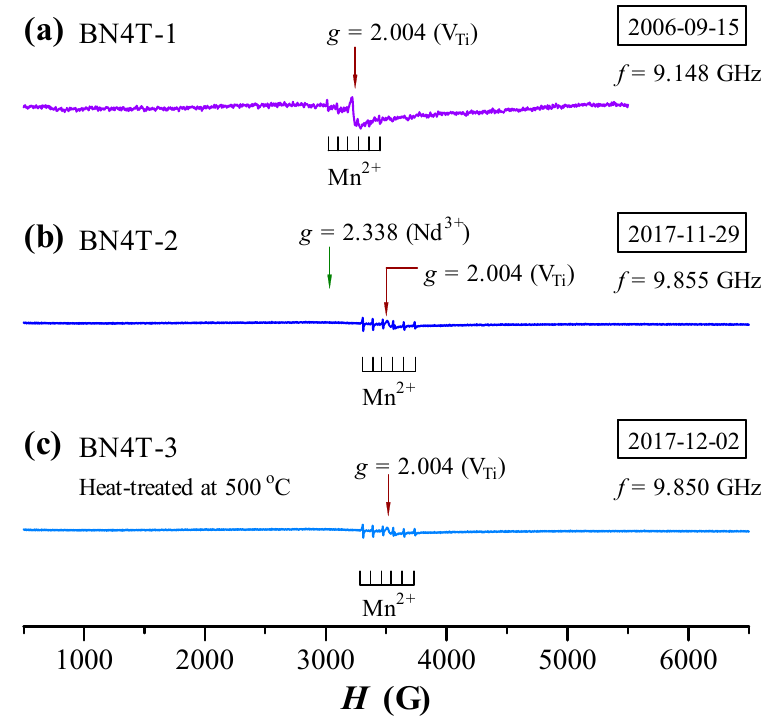
Figure 3. ESR spectra of BN4T in Table 1, measured ( a ) in 2006 using a JES-RE3X spectrometer (JEOL) and ( b , c ) in 2017 using an A300-10/12 spectrometer (Bruker, Billerica, MA, USA). A g = 2.004 signal associated with ionized Ti vacancies (V Ti ) (Equations (4) and (5)) [22,23] was detected for BN4T-1 prepared in 2006 because the dominant substitutions of Nd 3+ onto Ba sites create Ti vacancies (Equation (3)).